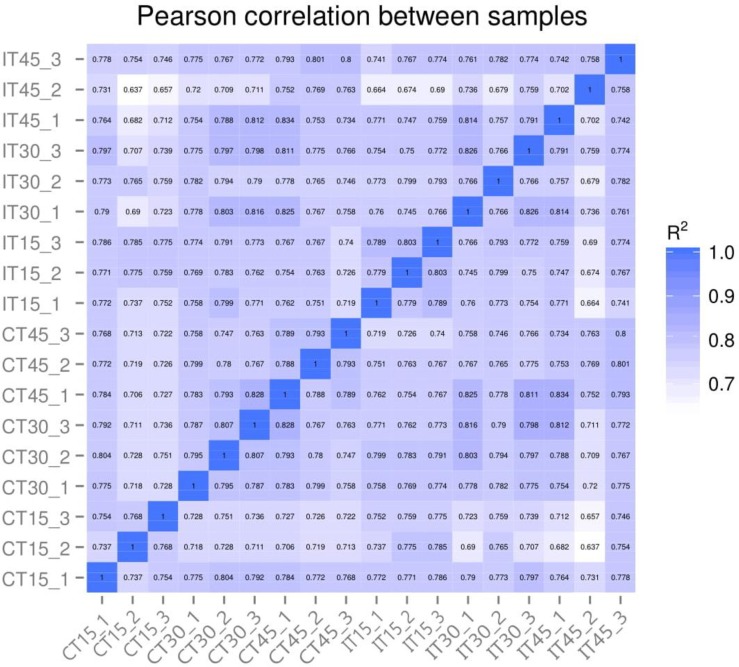
Pearson correlation between samples.